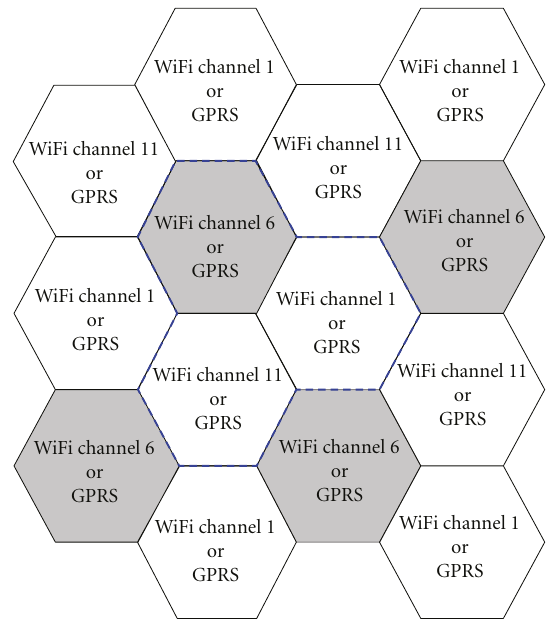
Figure 7: Channel planning of ISM channels in GPRS+WiFi coexistence